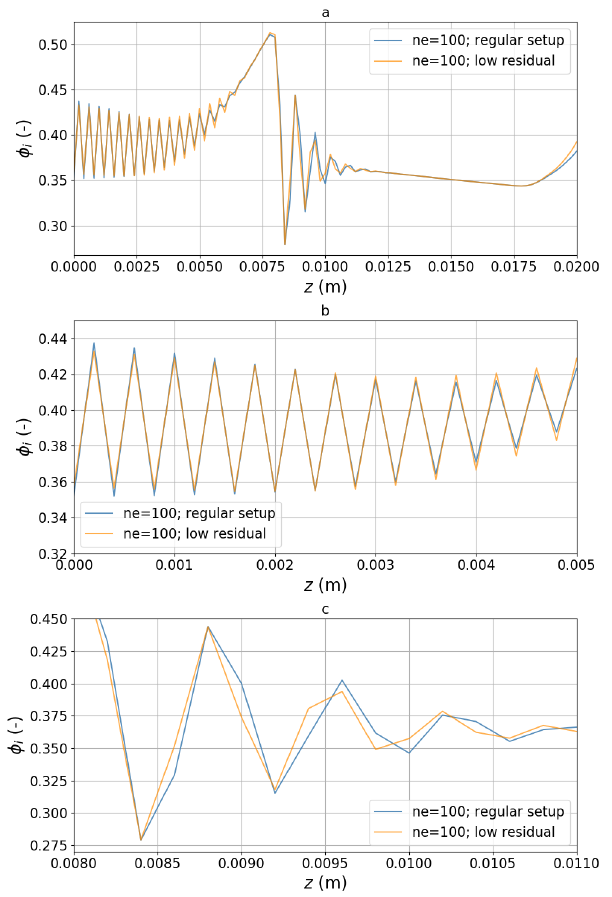
Figure B2. Comparison between node-to-node oscillation patterns for the regular setup and the low-residual